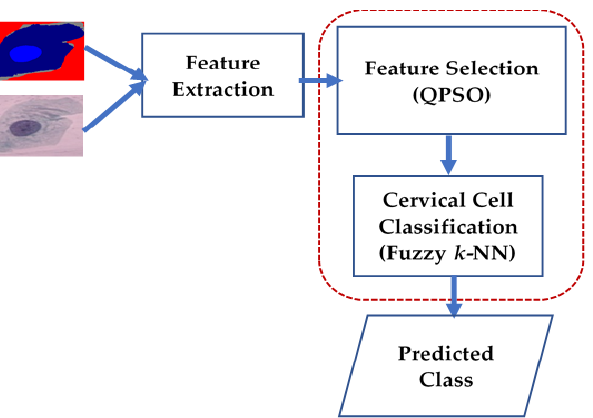
Figure 3. Layout of proposed quantum hybrid (Q-Fuzzy) technique to select and classify cells in smeared cervical images.